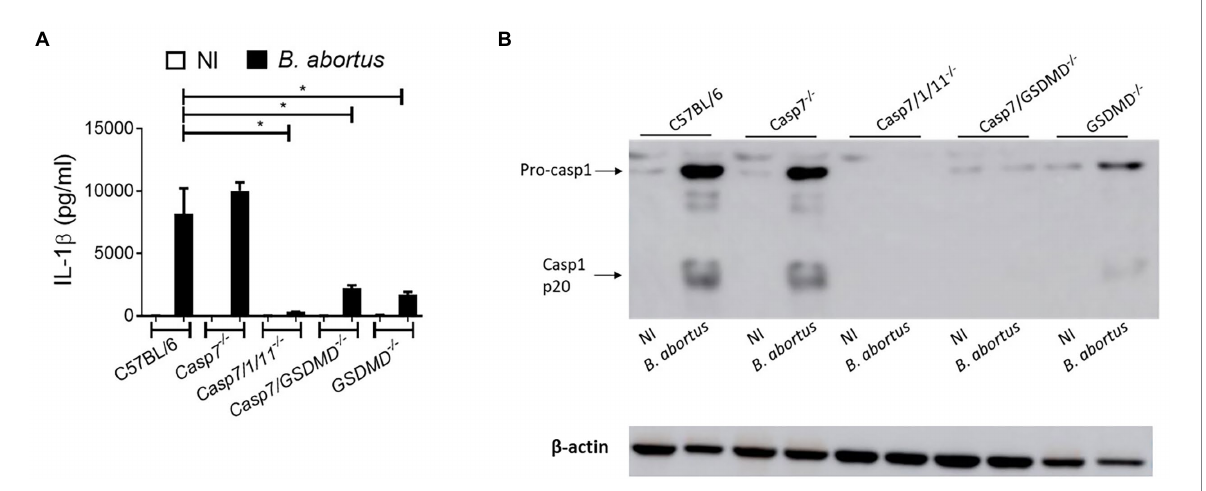
FIGURE 1 IL-1 β production in response to Brucella abortus occurs in a caspase-7-independent manner. BMDMs were infected with B. abortus MOI: 100 for 17 h. (A) IL-1 β measurement in the supernatant by ELISA. (B) Immunoblot analysis of caspase-1 processing. Data show the mean ± standard deviation of triplicates. The data are representative of three independent experiments. One-way ANOVA, * p < 0.05 compared to